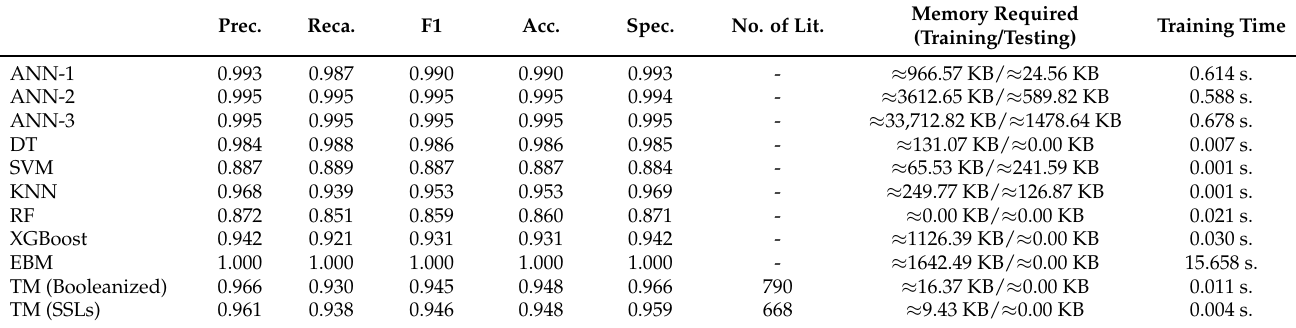
Table 13. Performance comparison for Balance Scale